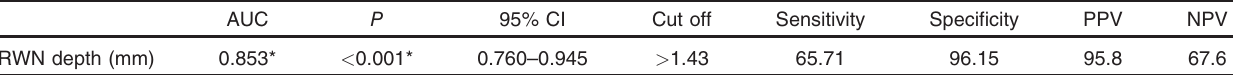
Table 5 Agreement (sensitivity, specificity) for round window niche depth (mm) to predict slit visible/invisible round window membrane